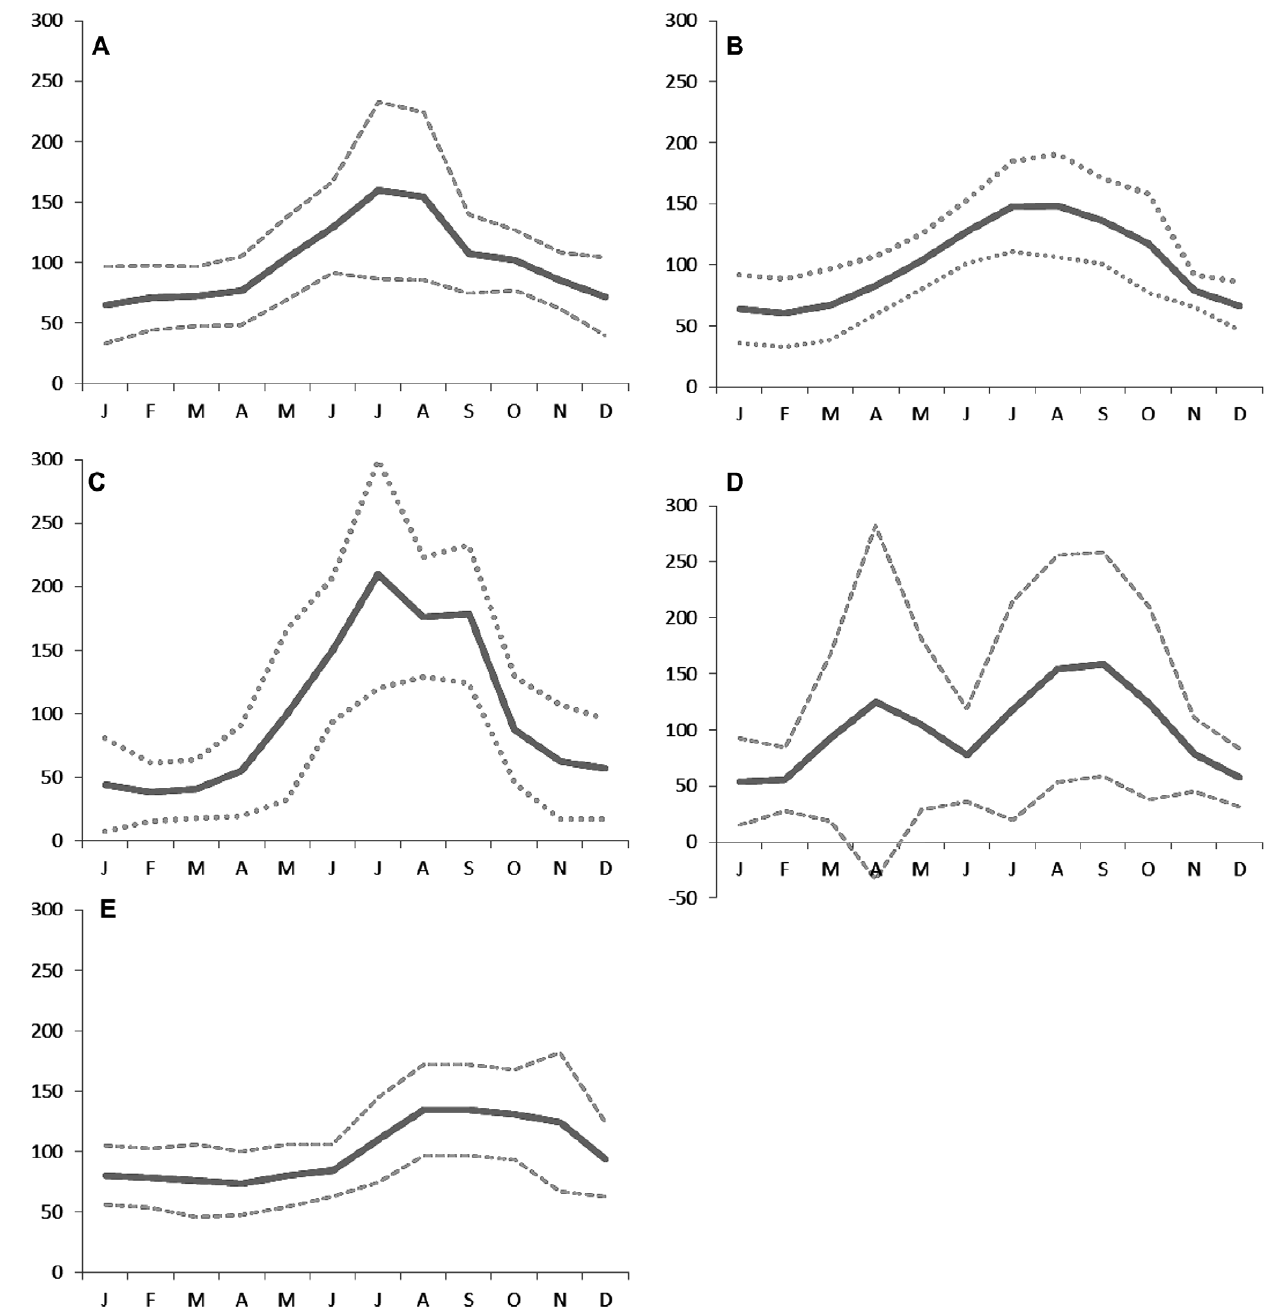
Figure 3. Disease specific overall monthly seasonality indices with plotted confidence intervals. Months and seasons shown refers to month/seasons of the northern hemisphere (i.e. January=month 1) and adjusted by six months for the southern hemisphere (i.e. January=month 7). Seasons are December, January, February (winter), March, April, May (spring), June, July, August (summer), September, October, November (autumn). CI of plus and minus one standard deviation is plotted. (A-campylobacteriosis, B-salmonellosis, C-VTEC, D-cryptosporidiosis,